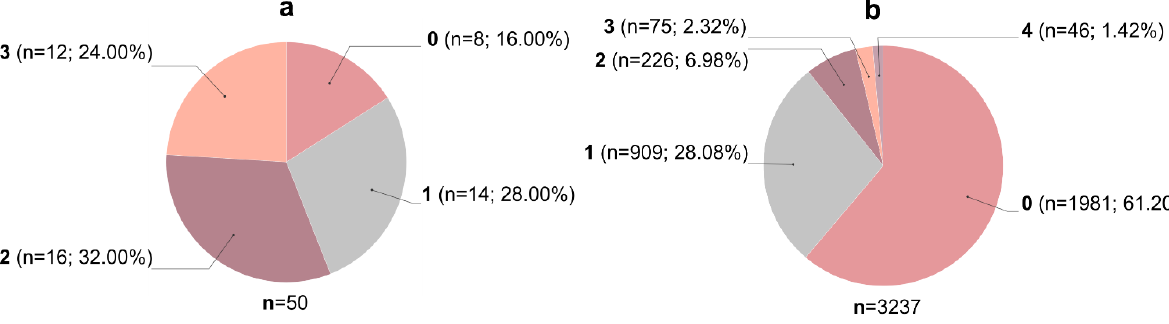
Figure 3. Toxicological profile of UV filters and Streptomyces -derived compounds. Toxicological effects such as irritant, mutagenic, tumorigenic, and reproductive effects were predicted using Datawarrior v5.5.0 software. The compounds were classified into group 0 (with “low” or “none” risk in the four parameters), group 1 (with “high” risk in at least one parameter), group 2 (with “high” risk in at least two parameters), group 3 (with “high” risk in at least three parameters), and group 4 (with “high” risk in the four parameters). ( a ) Approved organic UV filters; ( b ) filtered bad penetrants from Streptomyces ‐ derived compounds.